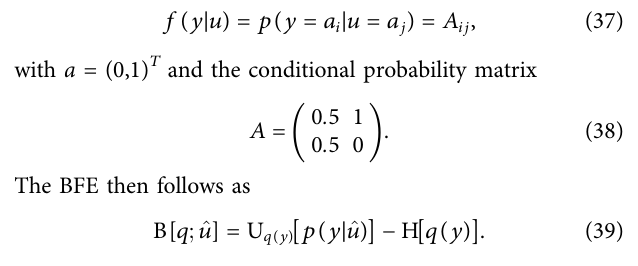
FIGURE 4 | Forney-style factor graph of the generative model for the T-maze. The MUX nodes select the transition matrix as determined by the control variable. Dashed boxes summarize the indicated